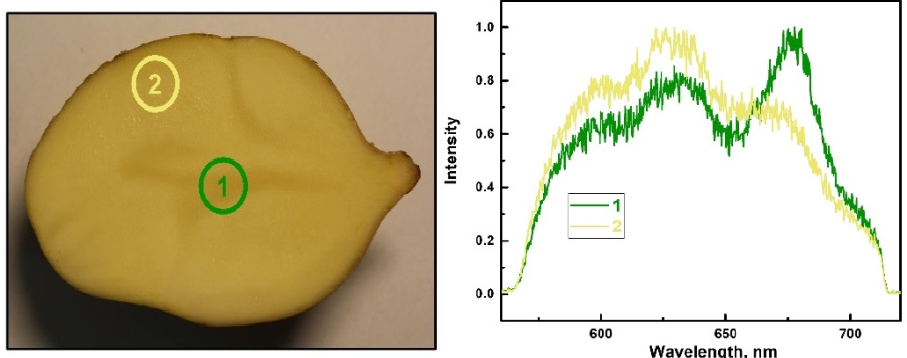
pared in Figure 10.